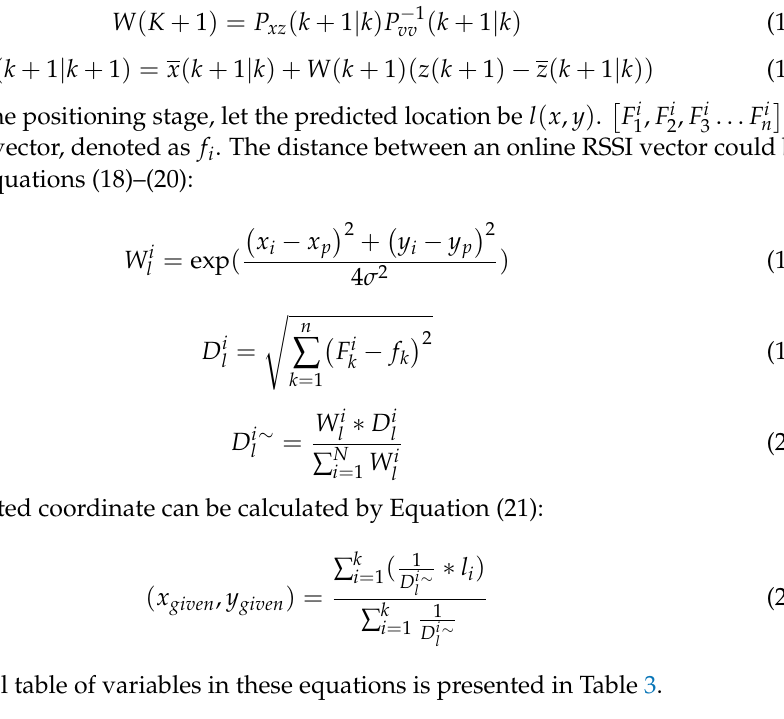
Table 3. The symbol table of variables which are used to predict a